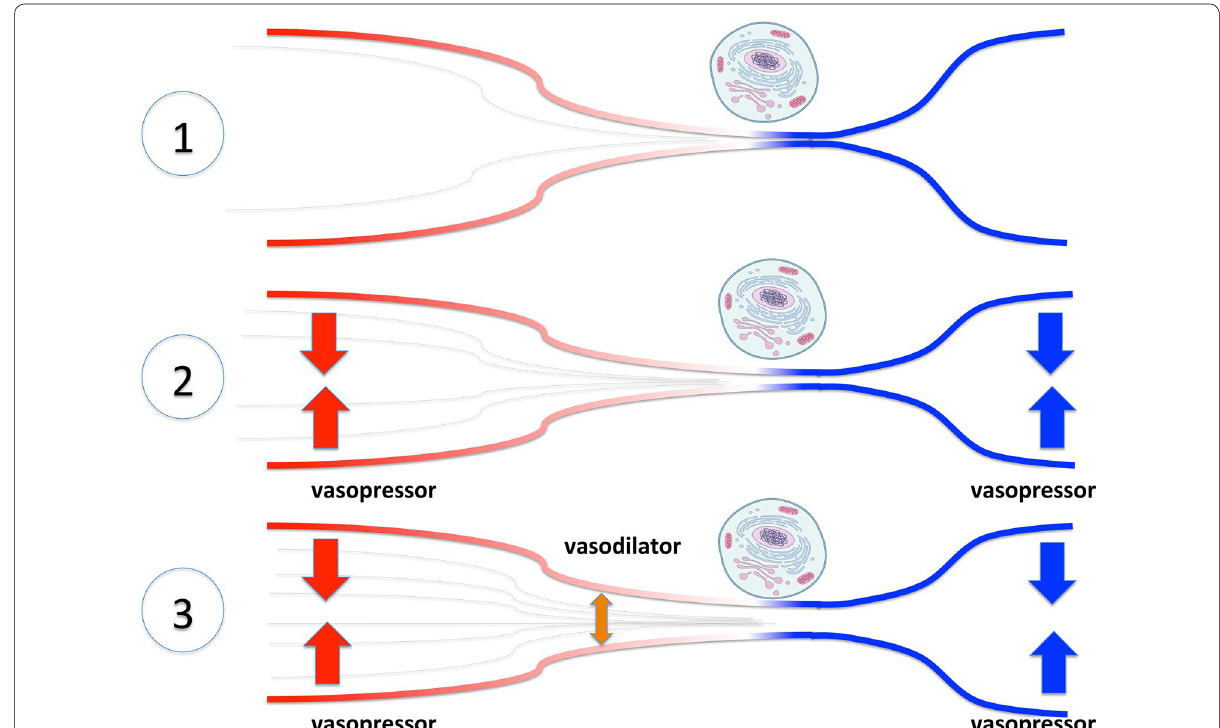
Fig. 1 Schematic representation of microvascular recruitment strategies of microvessels in distributive shock. Impaired tissue perfusion in distributive shock may be associated with low arterial pressure due to systemic vasodilation and intense vasoconstriction of precapillaries arterioles and external compression of capillaries in some vascular territories (Panel 1). Vasopressor agents increase inflow pressure by arteriolar vasoconstriction. Cardiac output can also increase due to venous constriction. Perfusion pressure may not increase despite the arterial pressure rise if the increase in perfusion pressure is insufficient to overcome precapillary vascular resistance and its closing critical pressure (Panel 2). This obstruction—theorized as a vascular bottleneck—might be targeted using vasodilators, which may improve microcirculatory flow and oxygen supply in selected patients (Panel